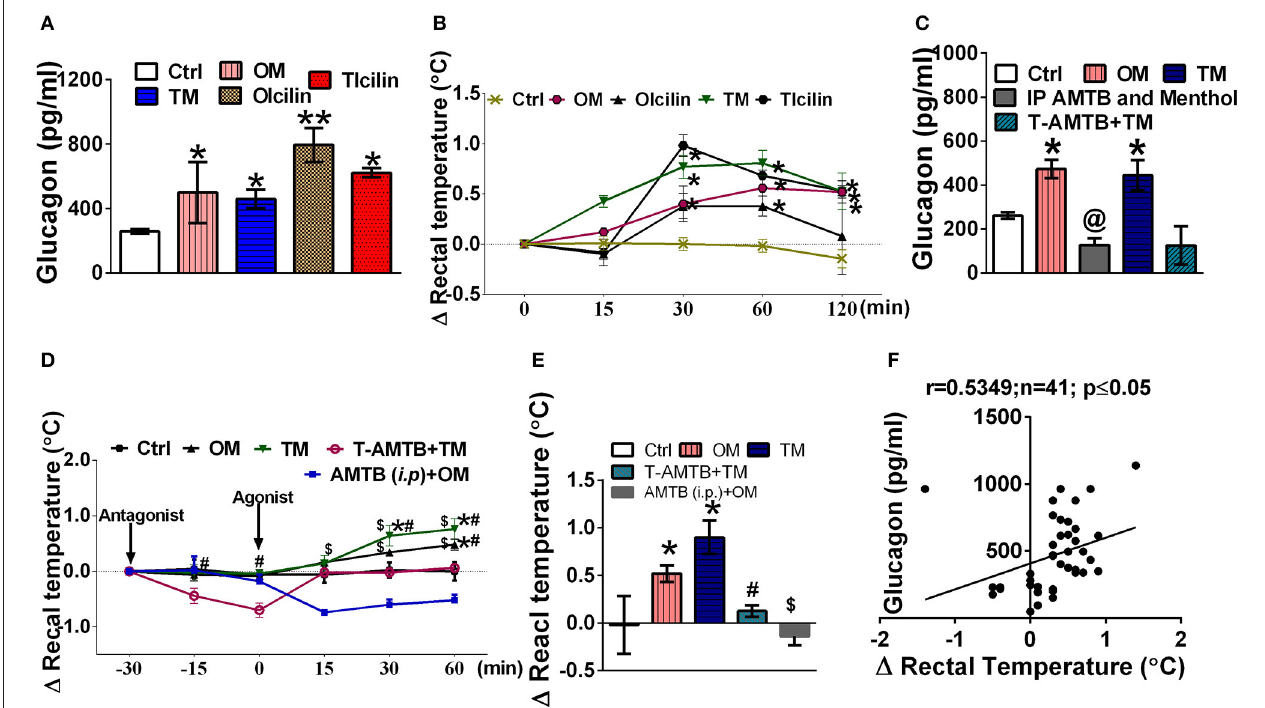
FIGURE 1 | TRPM8 activation increased serum glucagon level and rectal temperature. Effect of oral and topical administration of menthol and icilin on (A) serum glucagon levels after 120min of the treatment; (B) change in rectal temperature for 120min of the treatment; (C) serum glucagon levels after 120min in presence and absence of AMTB pre-treatment; (D) change in rectal temperature for 90min in presence and absence of AMTB pre-treatment, menthol ( p.o. ), and menthol topical was administered as a reference, (E) change in rectal temperature after 120min of the menthol treatment in presence and absence of AMTB pre-treatment, and (F) correlation between change in rectal temperature and serum glucagon levels after 120min of the treatment. Ctrl, vehicle treated animal; OM, menthol (per oral; 200 mg/kg); TM, menthol (10% topical application); OIcilin, icilin ( p.o. ; 20 mg/kg); TIcilin, icilin (1% topical application); T-AMTB + TM, AMTB (1% topical application) followed by menthol (10% topical application) 30min after AMTB; IP AMTB and menthol, AMTB (4 mg/kg i.p. ) followed by Menthol (200 mg/kg, p.o. ) 30min after AMTB. n = 5. All the values are expressed as mean ± S.E.M; ** p < 0.01 vs. Ctrl group, * p < 0.05 vs. Ctrl group, @ p < 0.05 vs. OM, $ p < 0.05 vs. AMTB ( i.p. ) + OM, and # p < 0.05 vs. T-AMTB + TM analyzed by one way ANOVA (A,C,E) or Repeated measure (RM) ANOVA (B,D) followed by Tukey’s multiple comparison; Spearman correlation analysis was performed in (F) .